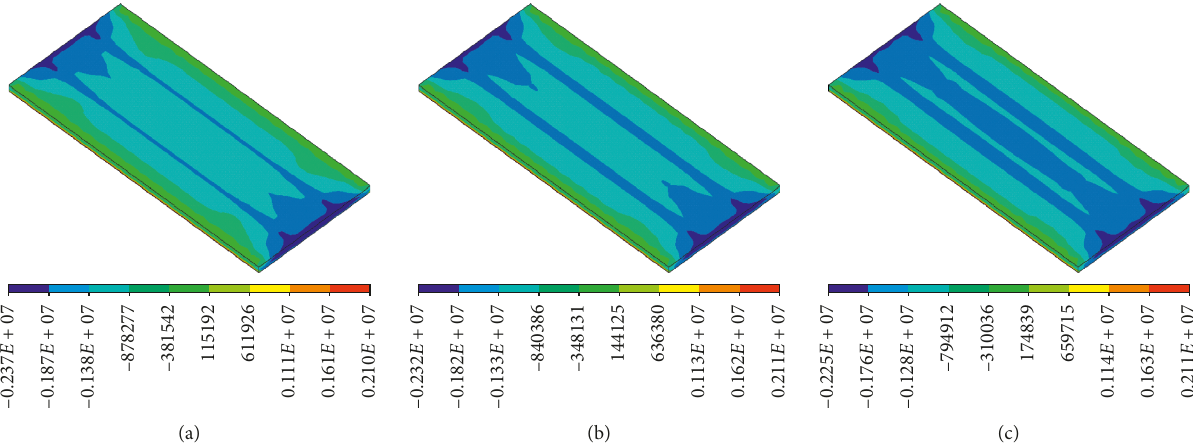
Figure 17: Transverse stress of the self-compacting concrete layer under condition 2. (a) P